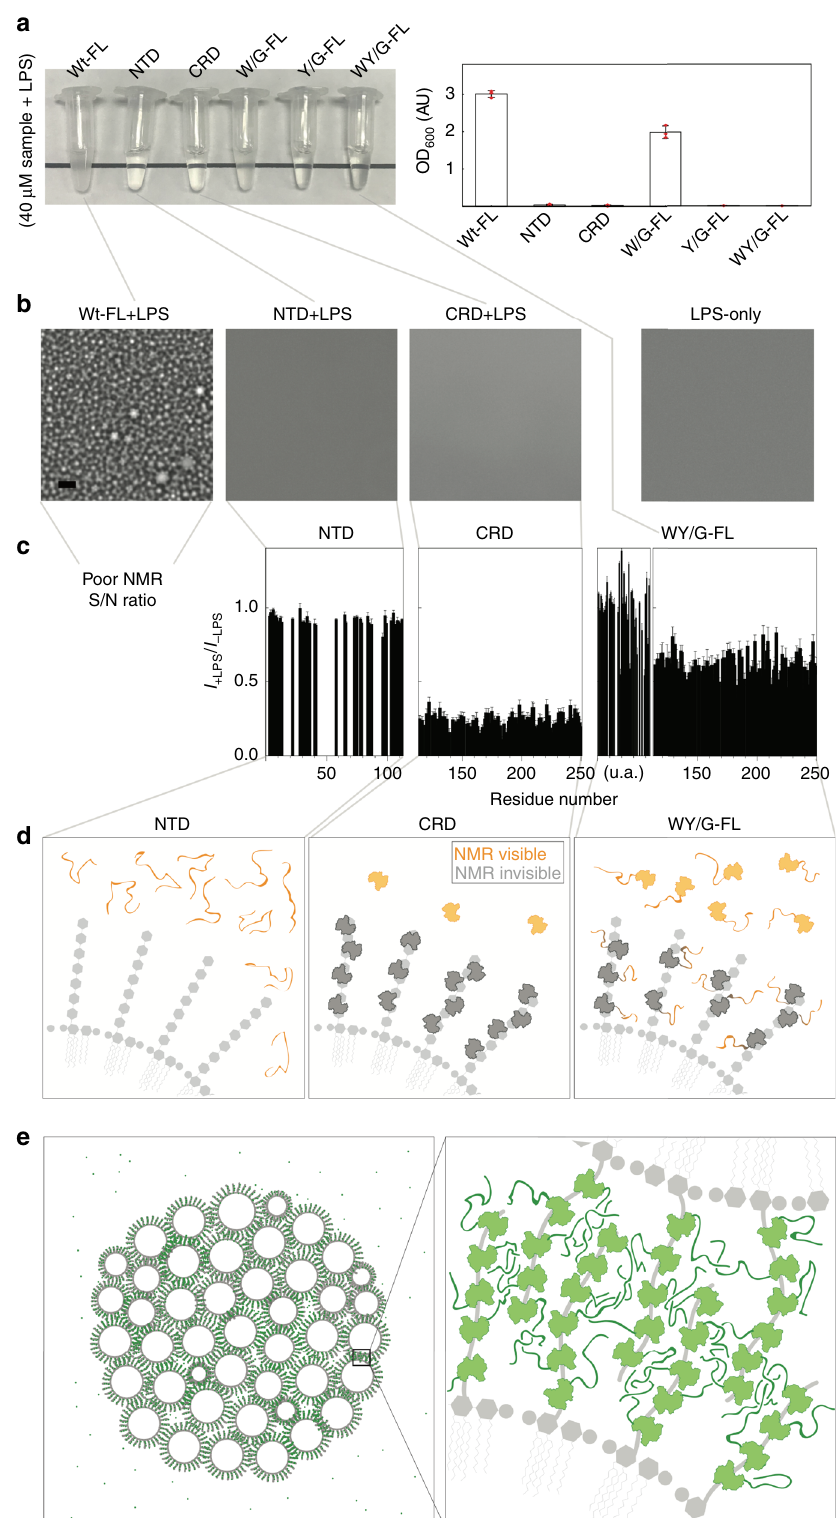
Fig. 5 Lipopolysaccharide (LPS) micelle agglutination assays. a Photograph and turbidity (O.D 600 ) ( n = 3 independent experiments; data are presented as mean values + / − SD) and ( b ) micrographs of samples of the different galectin-3 constructs in the presence of LPS. Experiments were performed at least three times for each protein sample (Scale bar: 10 µ m). c NMR peak intensity ratios in the presence and absence of LPS plotted as a function of residue number for the N-terminal domain (NTD)-only, carbohydrate-recognition domain (CRD)-only, and WY/G constructs. (This analysis was not possible for the full-length wild type because of a poor signal-to-noise ratio (Supplementary Fig. 8). d Schematic illustrations explaining the intensity changes for the NTD-only, CRD-only, and WY/G constructs. e Schematic illustration of the proposed mechanism of LPS-micelle agglutination driven by full-length wild-type